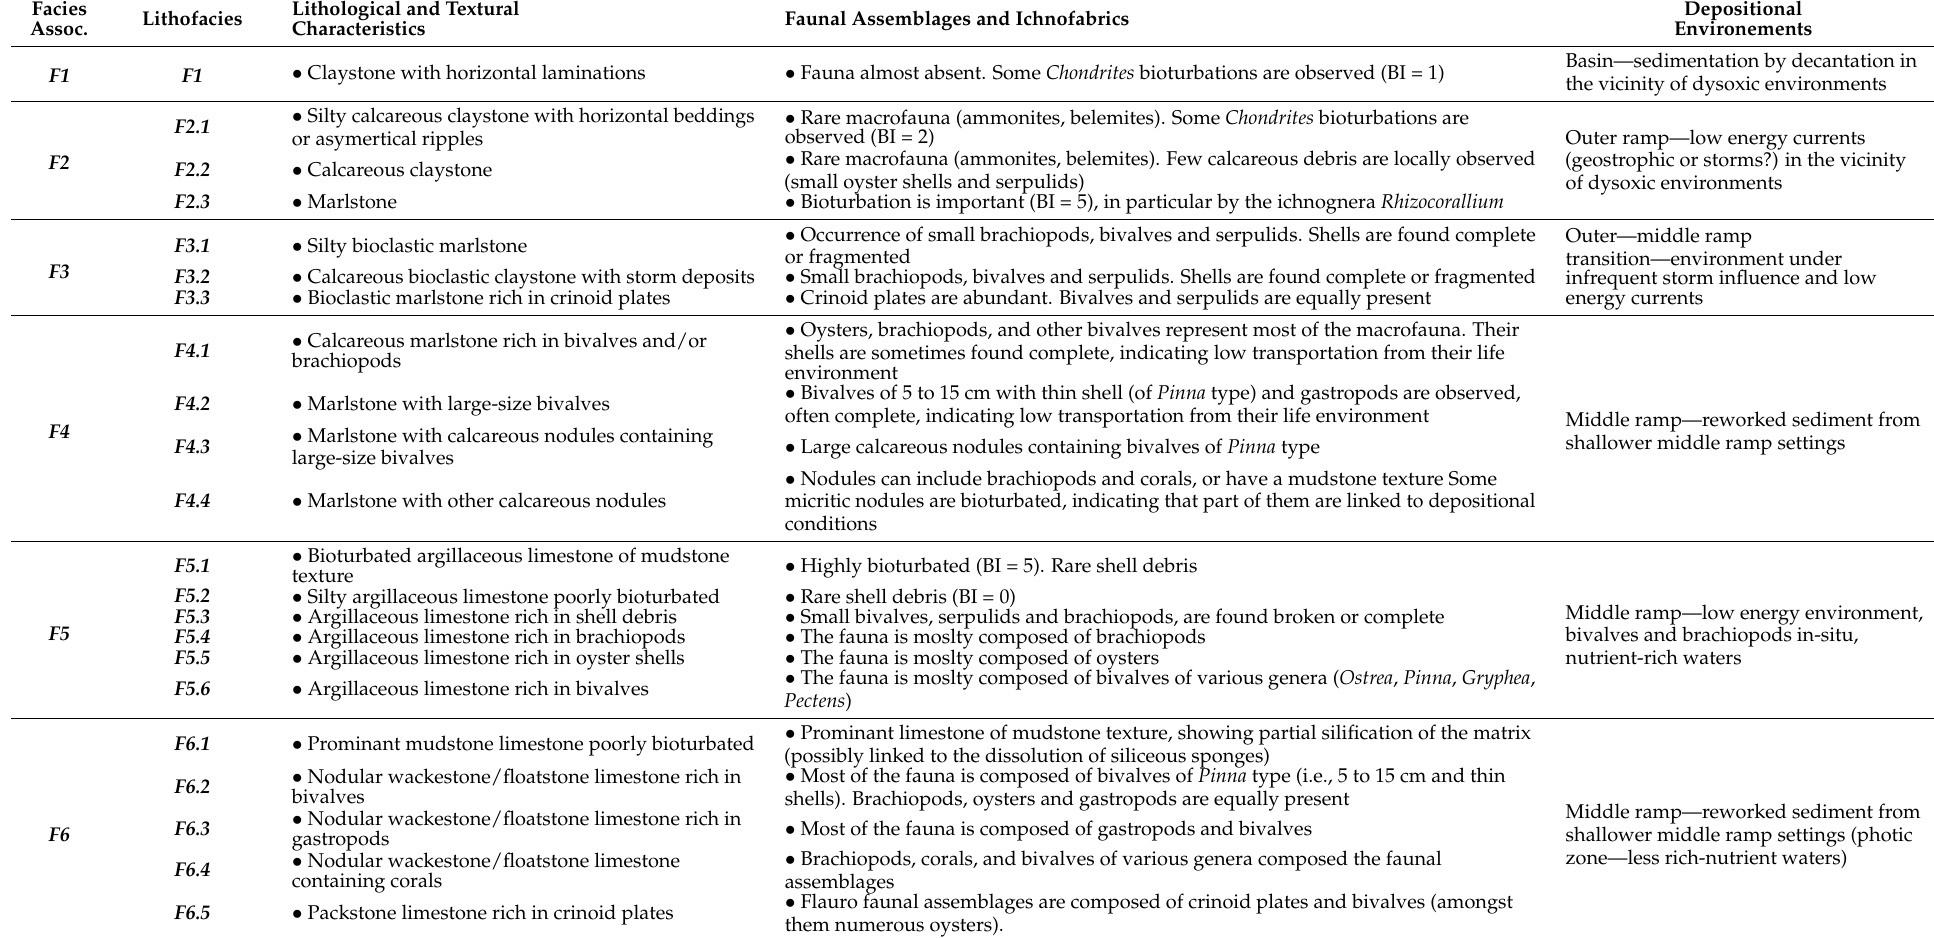
Table 1. Description of lithofacies, classification into facies associations and interpretations in terms of depositional environments. Facies